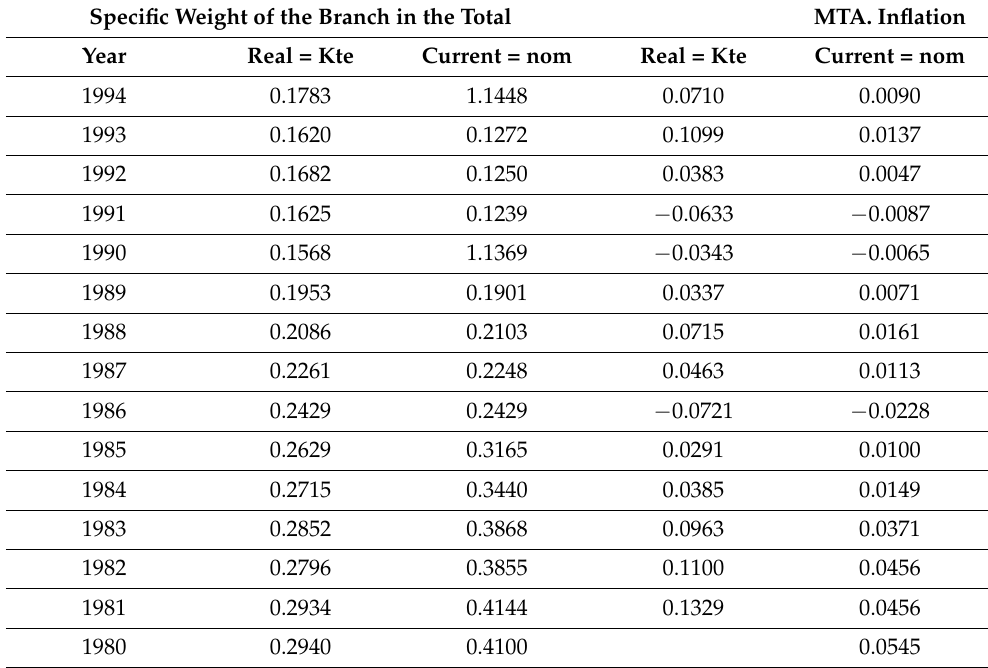
Table 7. Specific weight of maritime transport: contribution to inflation. Specific Weight of the Branch in the